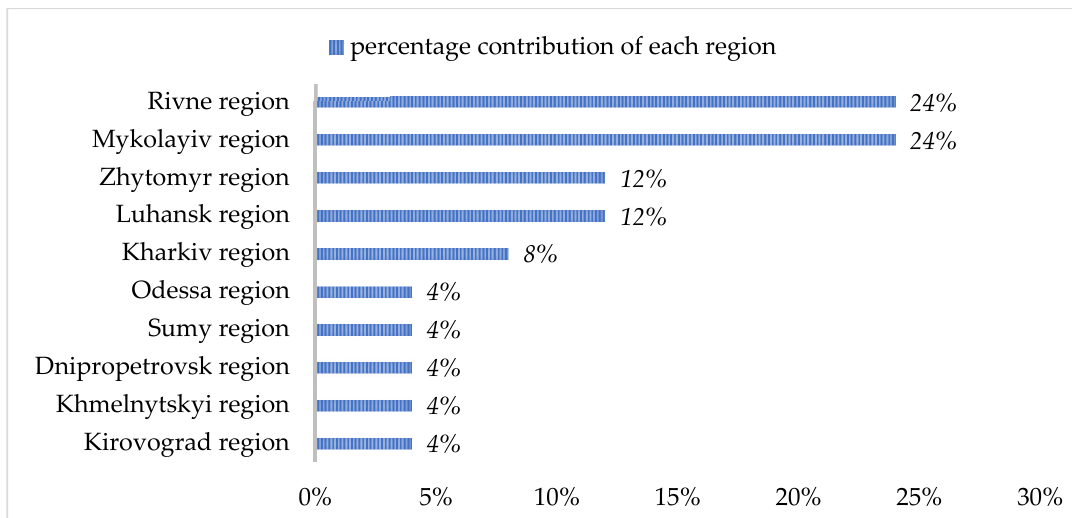
Figure 4. Percentage of each region’s participation in the survey (by the pharmacies quantity). For the estimation of functioning and the effectiveness of QAS implementation in pharmacies, the average mark of the risks assessment values for each compounding pharmacy that participated in the study was calculated (Figure 5).